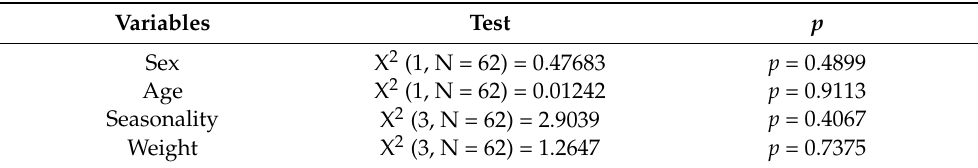
Figure 3. Sites of trapped B. procyonis -positive raccoons (the proximity of some trapping sites results in the overlapping of dots in the picture). Table 5. Statistical analysis showing no relationship between B. procyonis positivity and the four considered variables (sex, age, seasonality,